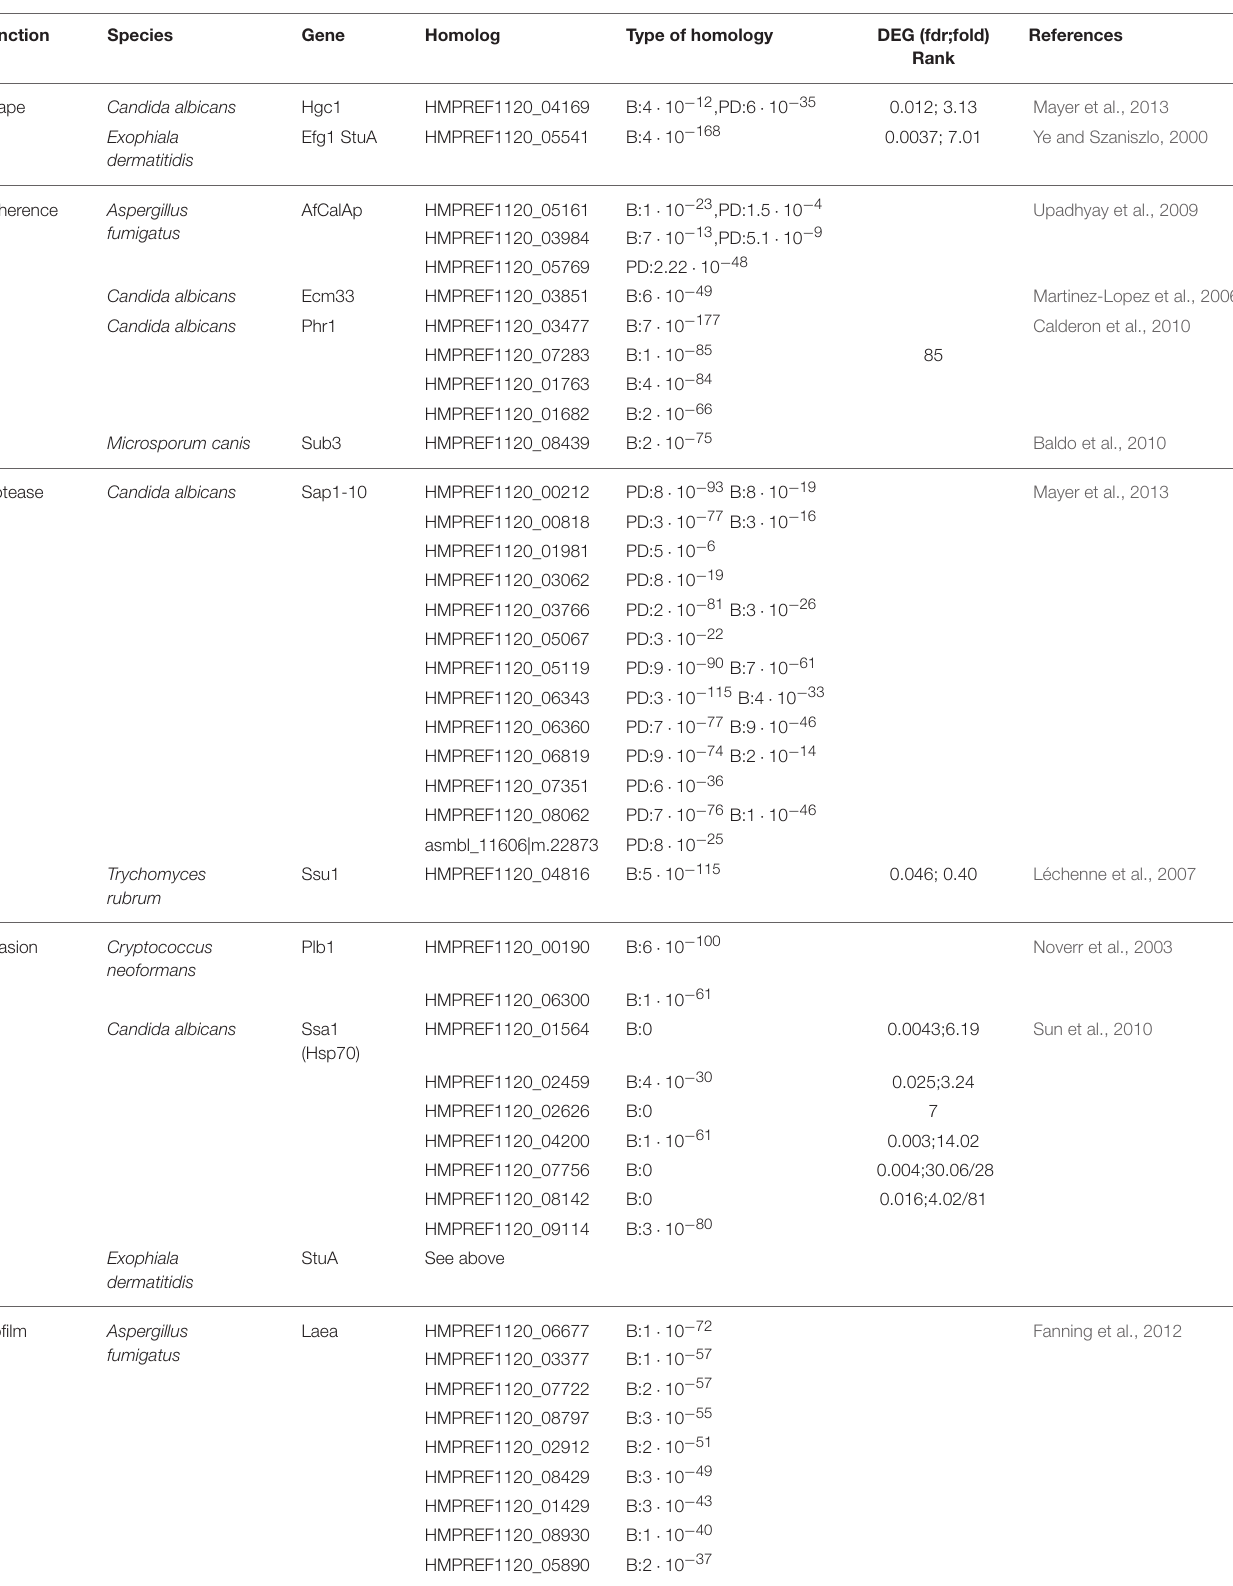
TABLE 1 | List of fungal virulence factors found in Exophiala dermatitidis .